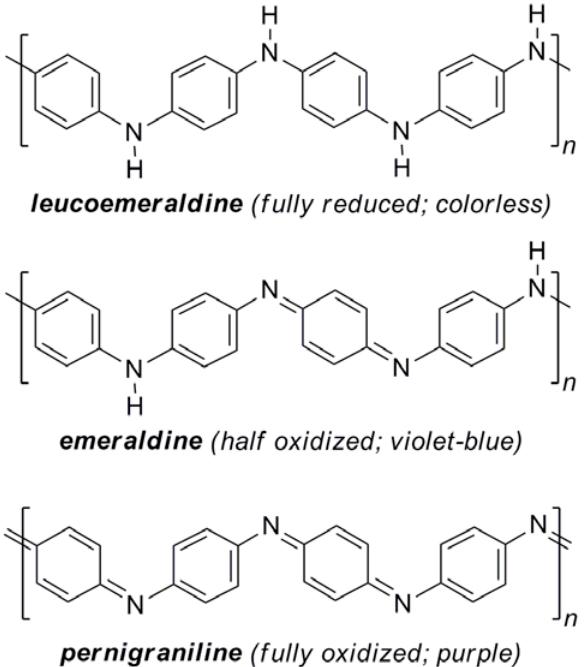
Figure 2. Primary oxidation states of